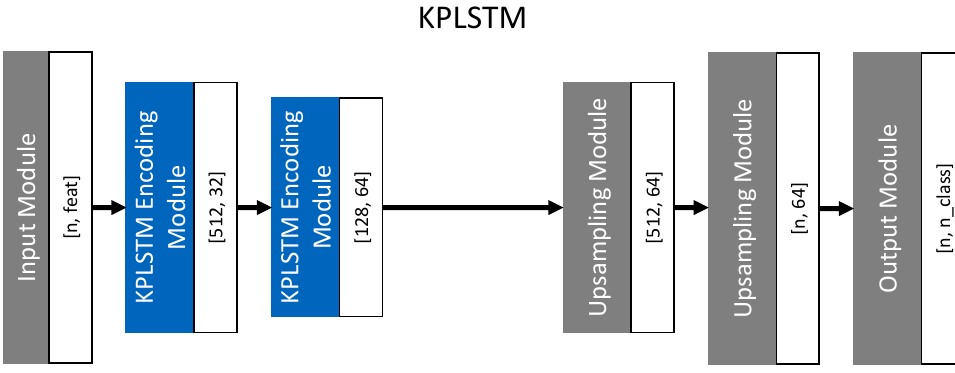
Figure 5. High-level structure of the KPLSTM model. The time dependency is already considered in the encoding stage as indicated by the blue